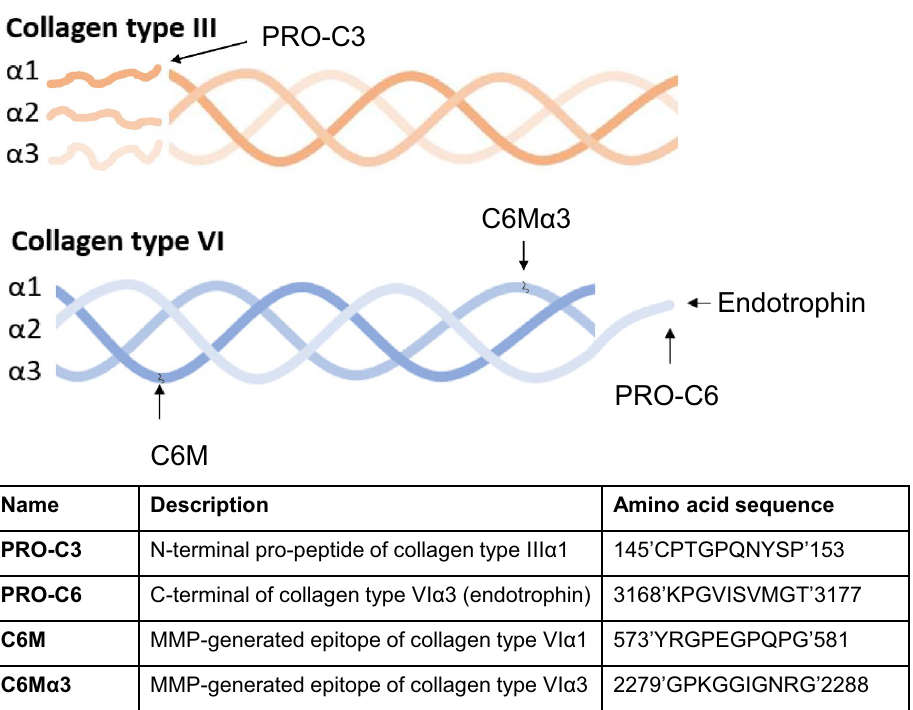
Figure 1. Schematic illustration of collagen type III and type VI with descriptions of their respective biomarker